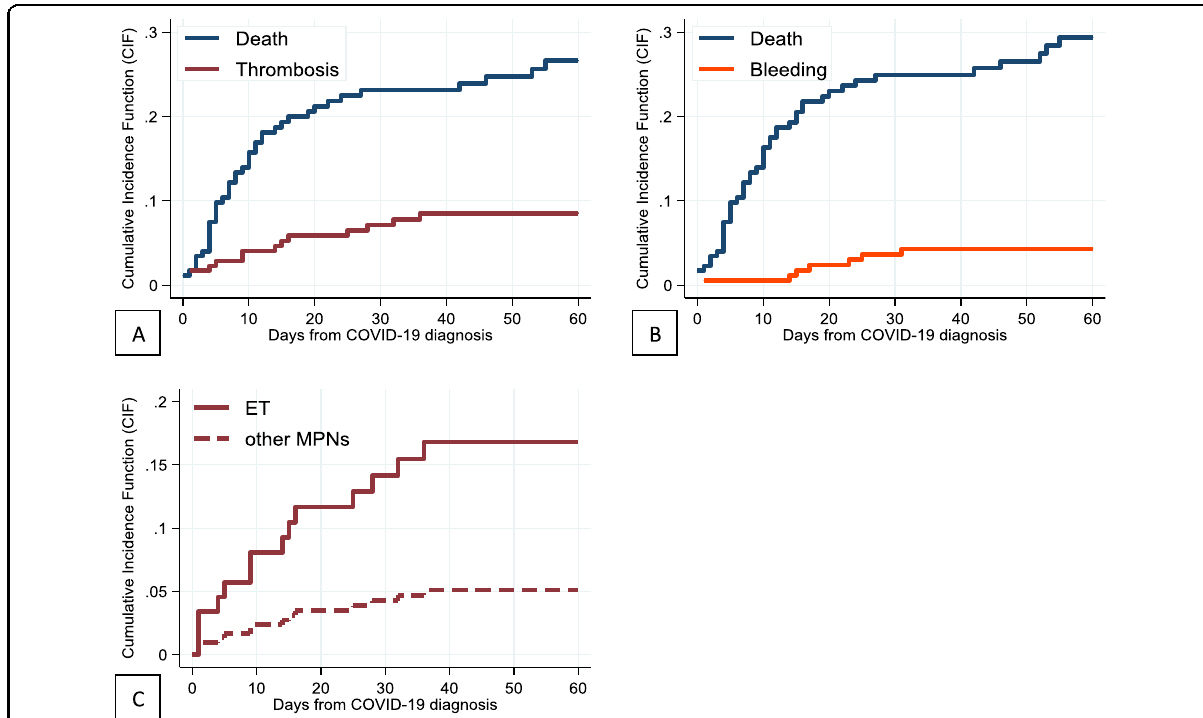
Fig. 1 Cumulative incidence of thrombosis and bleeding. Cumulative Incidence Function (CIF) of thrombosis overall ( A ) and by MPN phenotypes ( C ), and bleeding ( B ), considering death as competing